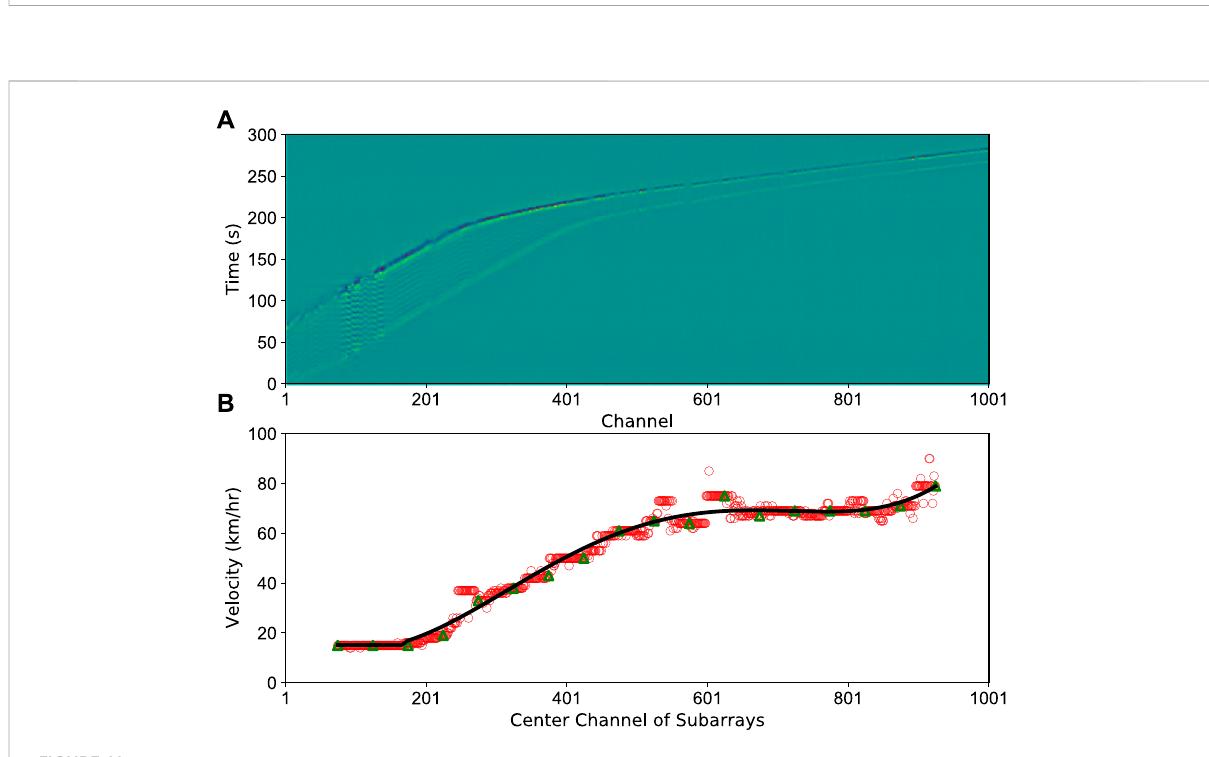
FIGURE 11 Speed and motion track estimation for a variable-speed train case. (A) Train-induced signals; (B) Detection results and speed distribution. Red circles denote the speed results estimated by moving subarrays with 149-channel overlapping, while green triangles denote the results with 100- channel overlapping. The black curve is the smoothed result of the green